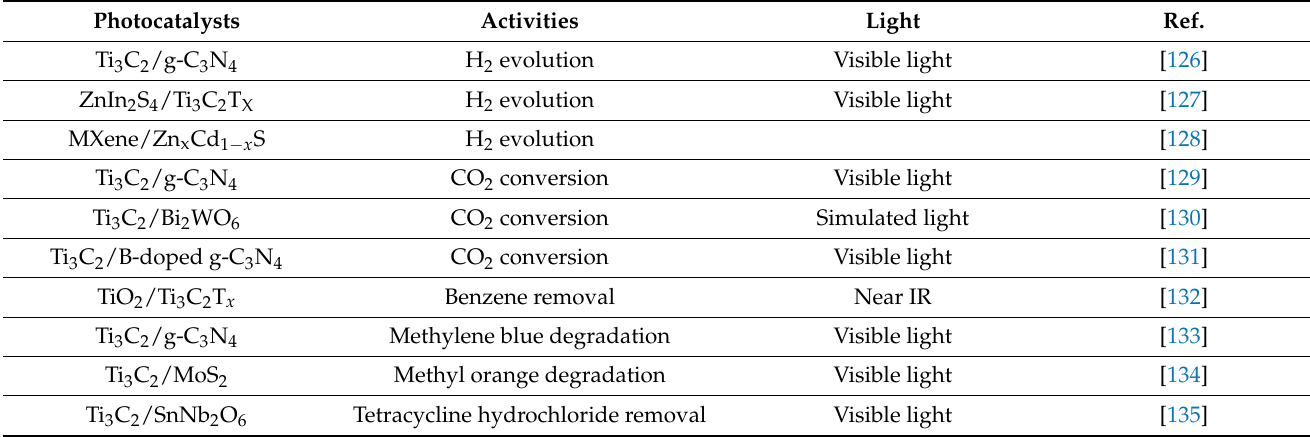
Table 3. Summary of the photocatalytic performance of MXene-based